Question: Write the caption for this figure.
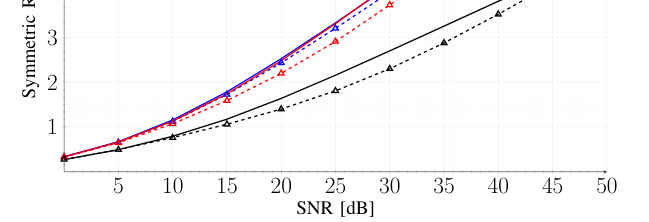
Answer: Average symmetric rate versus SNR with random user-to-proﬁle association, K = 30, L = 10, ¯t = 1, P = 5, γ = 0.2, ˆη = η1 and α ∈{8, 10}. The average symmetric rate is taken over all possible ηp values.